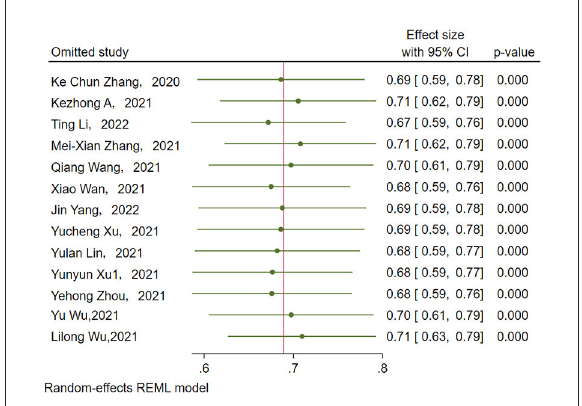
FIGURE4 Forest plot of influential analysis on incidence studies.